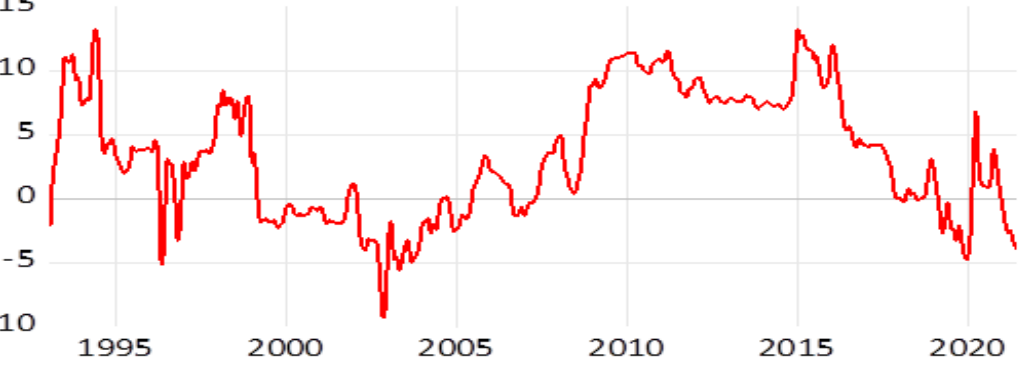
Figure 8. Volatility spillover from oil price to foreign liabilities.